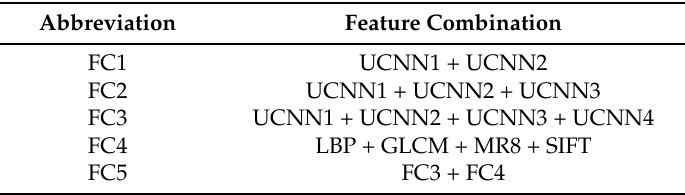
Table 3. Exploited feature combinations.